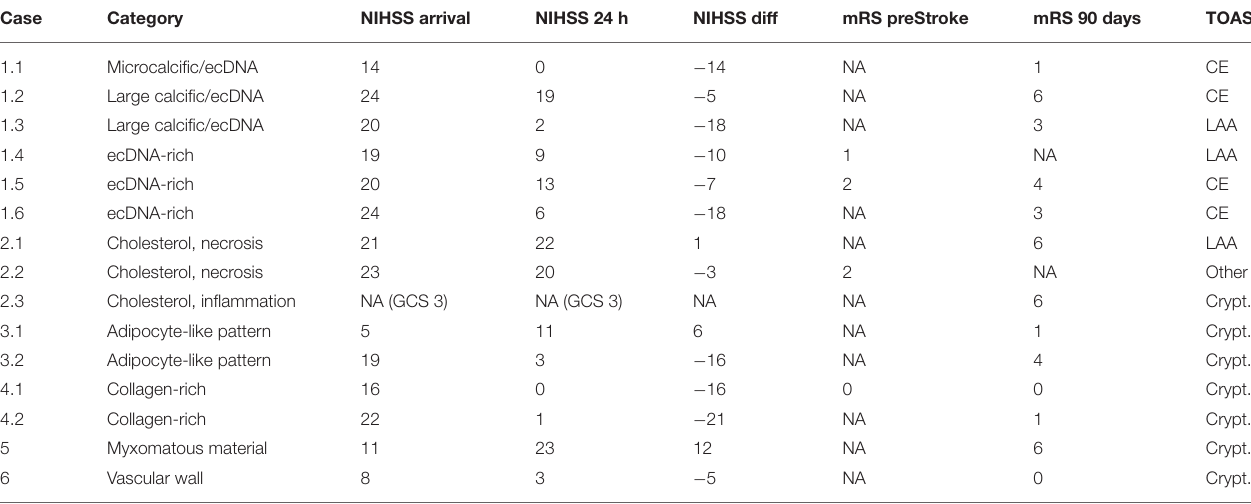
TABLE 2 | Neurologic disability of included patients and stroke etiology according to TOAST-system. Case